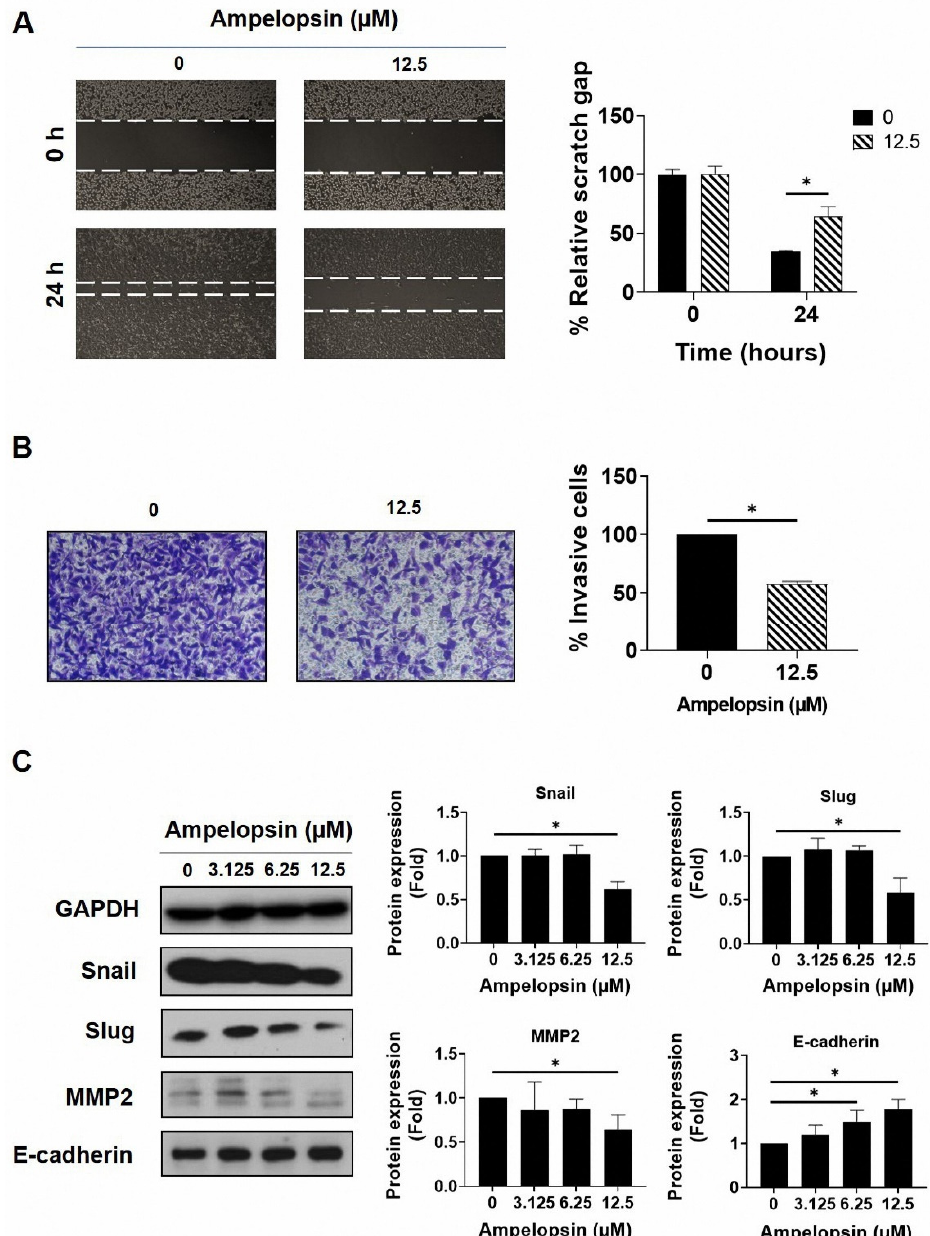
Figure 3. The inhibitory potential of ampelopsin on invasion and migration by MDA-MB-231/IR cells. ( A ) The cell invasion assay was used to measure the invasive cells following treatment 24 h with ampelopsin (12.5 µM). Images were obtained by phase-contrast microscopy (100× magnification). ( B ) Migrated cells after 24 h treatment with ampelopsin was determined by wound healing assay. Images were obtained by phase-contrast microscopy (100× magnification). ( C ) Western blotting analysis was performed for epithelial–mesenchymal transition (EMT) markers following treatment with ampelopsin for 24 h. GAPDH was used as the loading control. Original films were shown in Figure S5. * p < 0.05 vs. control.